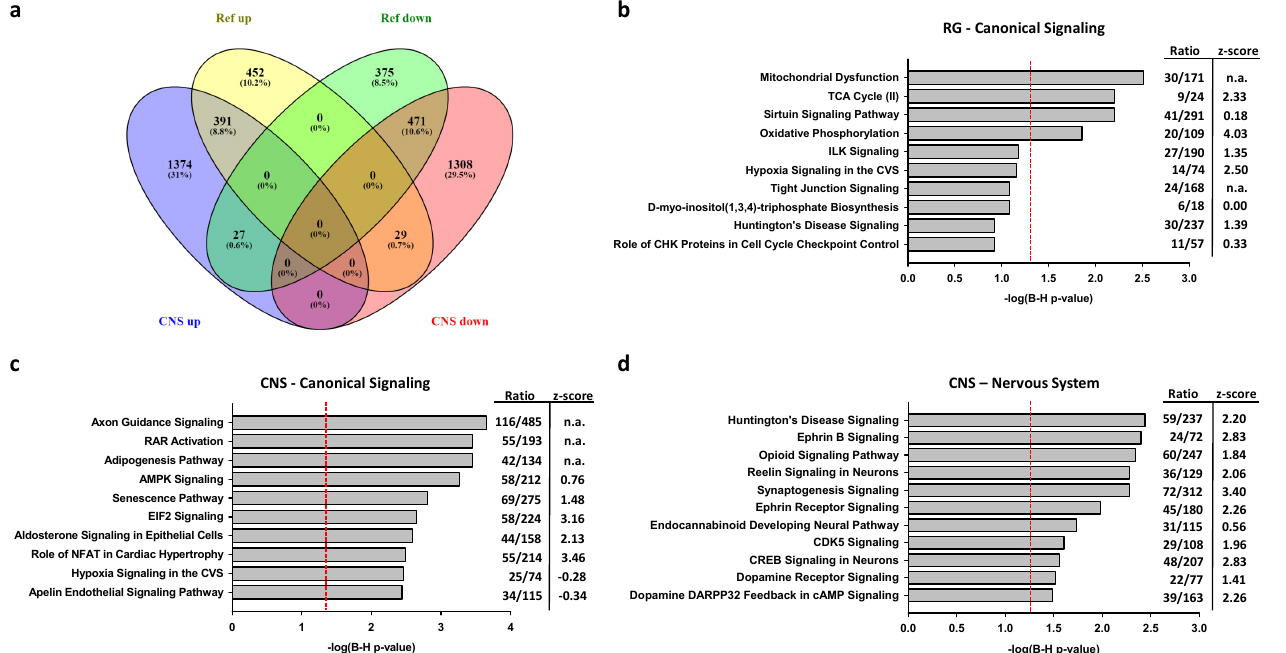
Figure 4. Differentially expressed genes resulting from activation of the RG or CNS promoters reveal promoter selectivity with partial overlap. ( a ) Venn diagram of differentially expressed genes (DEGS) produced by transfection of clonal SH-SY5Y cells expressing dCas9-VPR with sgRNAs activating the RG or the CNS promoters are compared with cells transfected with scrambled sgRNAs. ( b , c ) Top canonical signaling pathways for DEGs after RG or CNS promoter activation, respectively. ( d ) Top nervous system signaling pathways for DEGs after CNS promoter activation; red lines refer to adjusted p -values of 0.05; z -scores > 2.0 or < − 2.0 are significant and indicate the direction for the expected entity; n.a, not available; B-H, Bernini-Hochberg adjusted p -values for multiple testing.